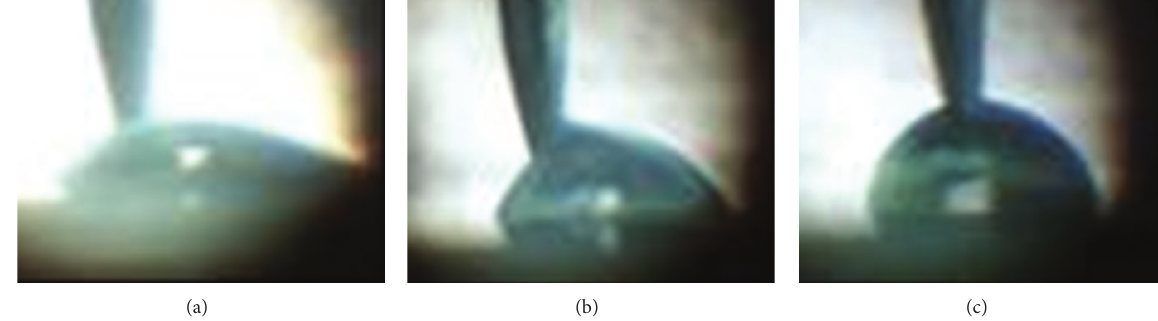
Figure 3: Water droplets on SinA monolayer during the advance wetting angle measurements: (a) as-prepared, (b) irradiated for 15h, and (c) irradiated for 24 h.